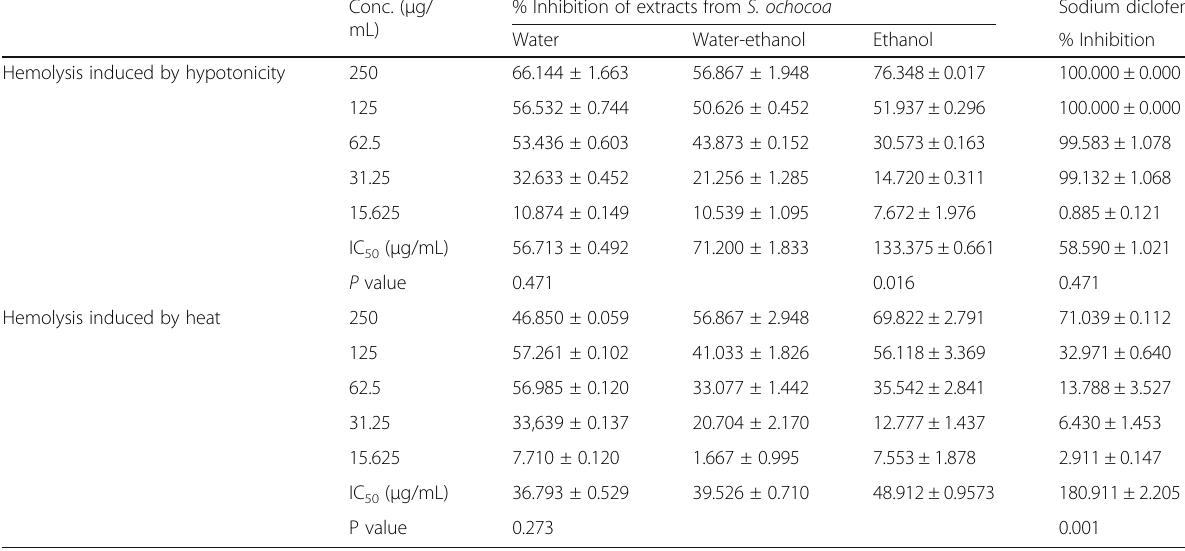
Table 5 Effect of S. ochocoa extracts and diclofenac sodium against membrane stabilization